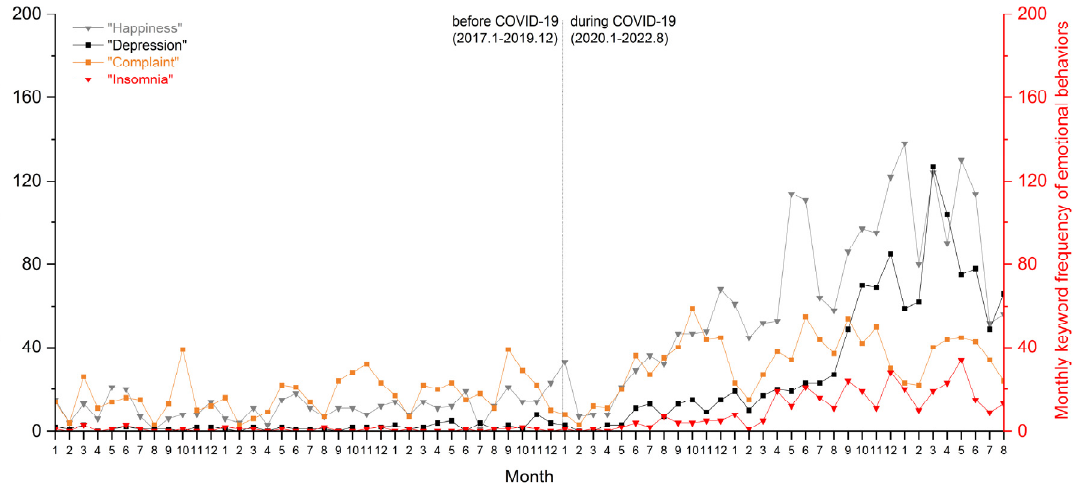
Figure 9. Monthly keyword frequency about emotional conditions: “Happiness”, “Depression”, “Complaint”, and “Insomnia”.